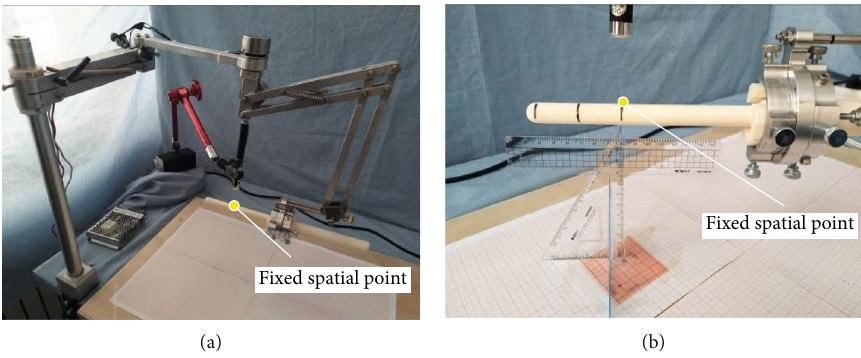
Figure 13: Measurement of azimuth remote center point error: (a) overall view; (b) partial magni fi cation view.